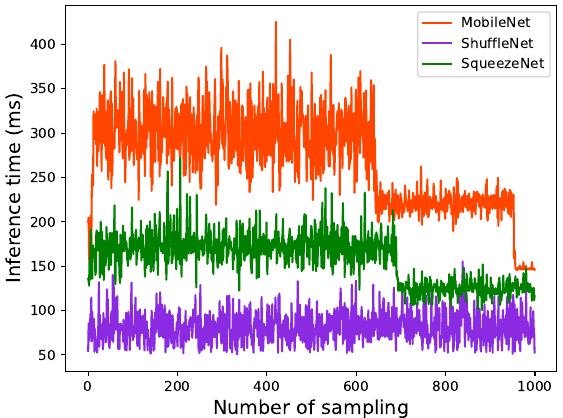
Figure 8. Inference time of each model without scheduling.